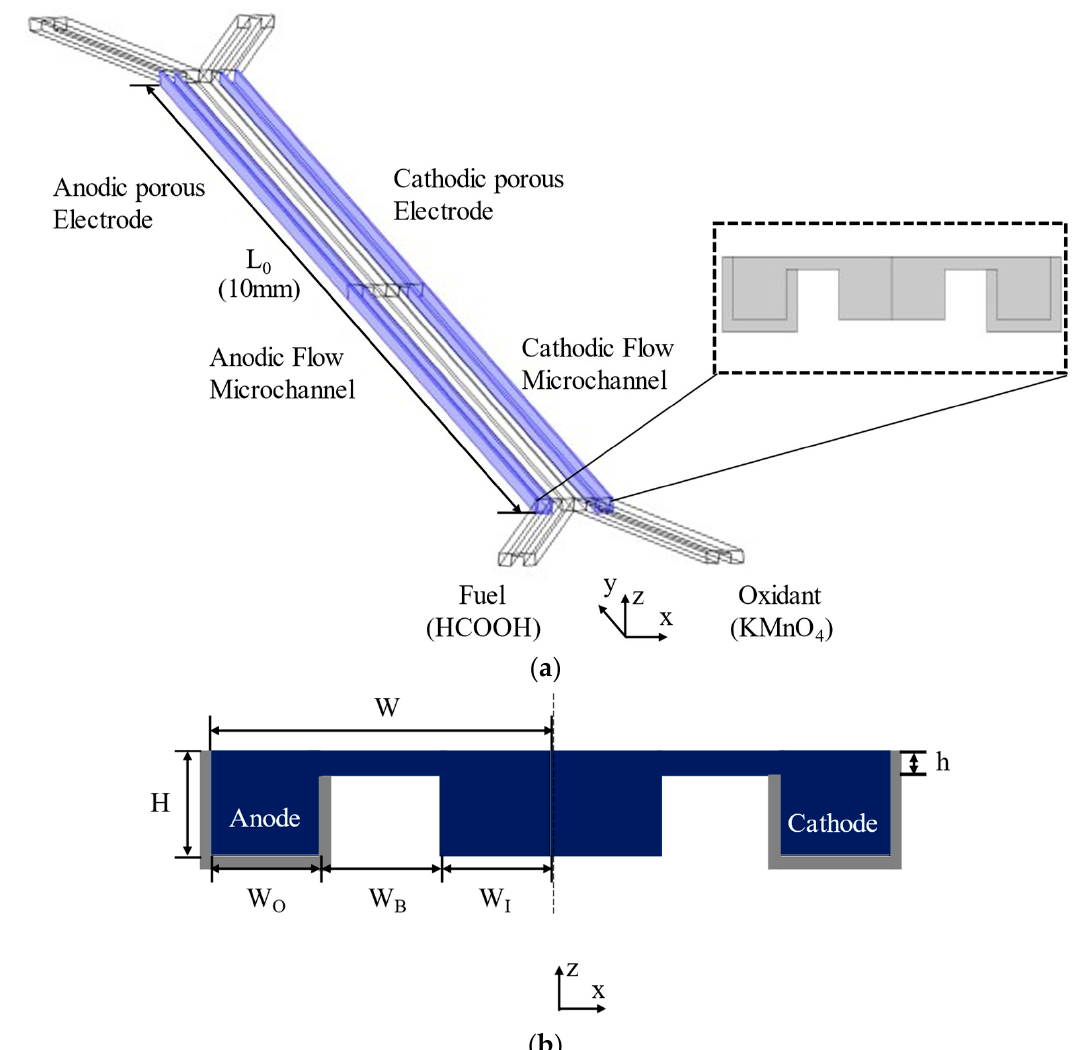
Figure 1. Double-bridge shaped MMFC channel. ( a ) Flow channel and electrode locations, ( b ) channel cross-section (grey regions indicate electrodes).